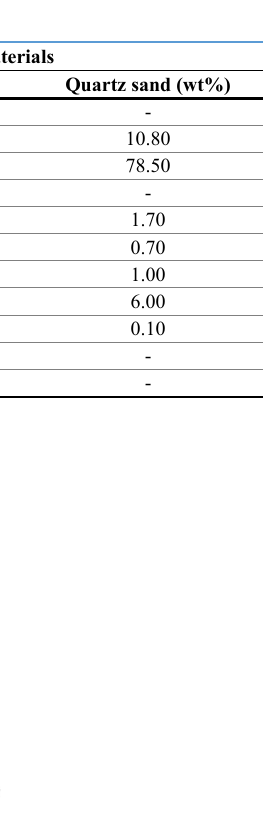
Figure 1. XRD pattern of the iron ore tailing in nature and quartz sand (B-biotite; C-chamosite; cl-chantalite; Q-quartz; G-goethite; H-hematite; M-microcline; P-periclase).